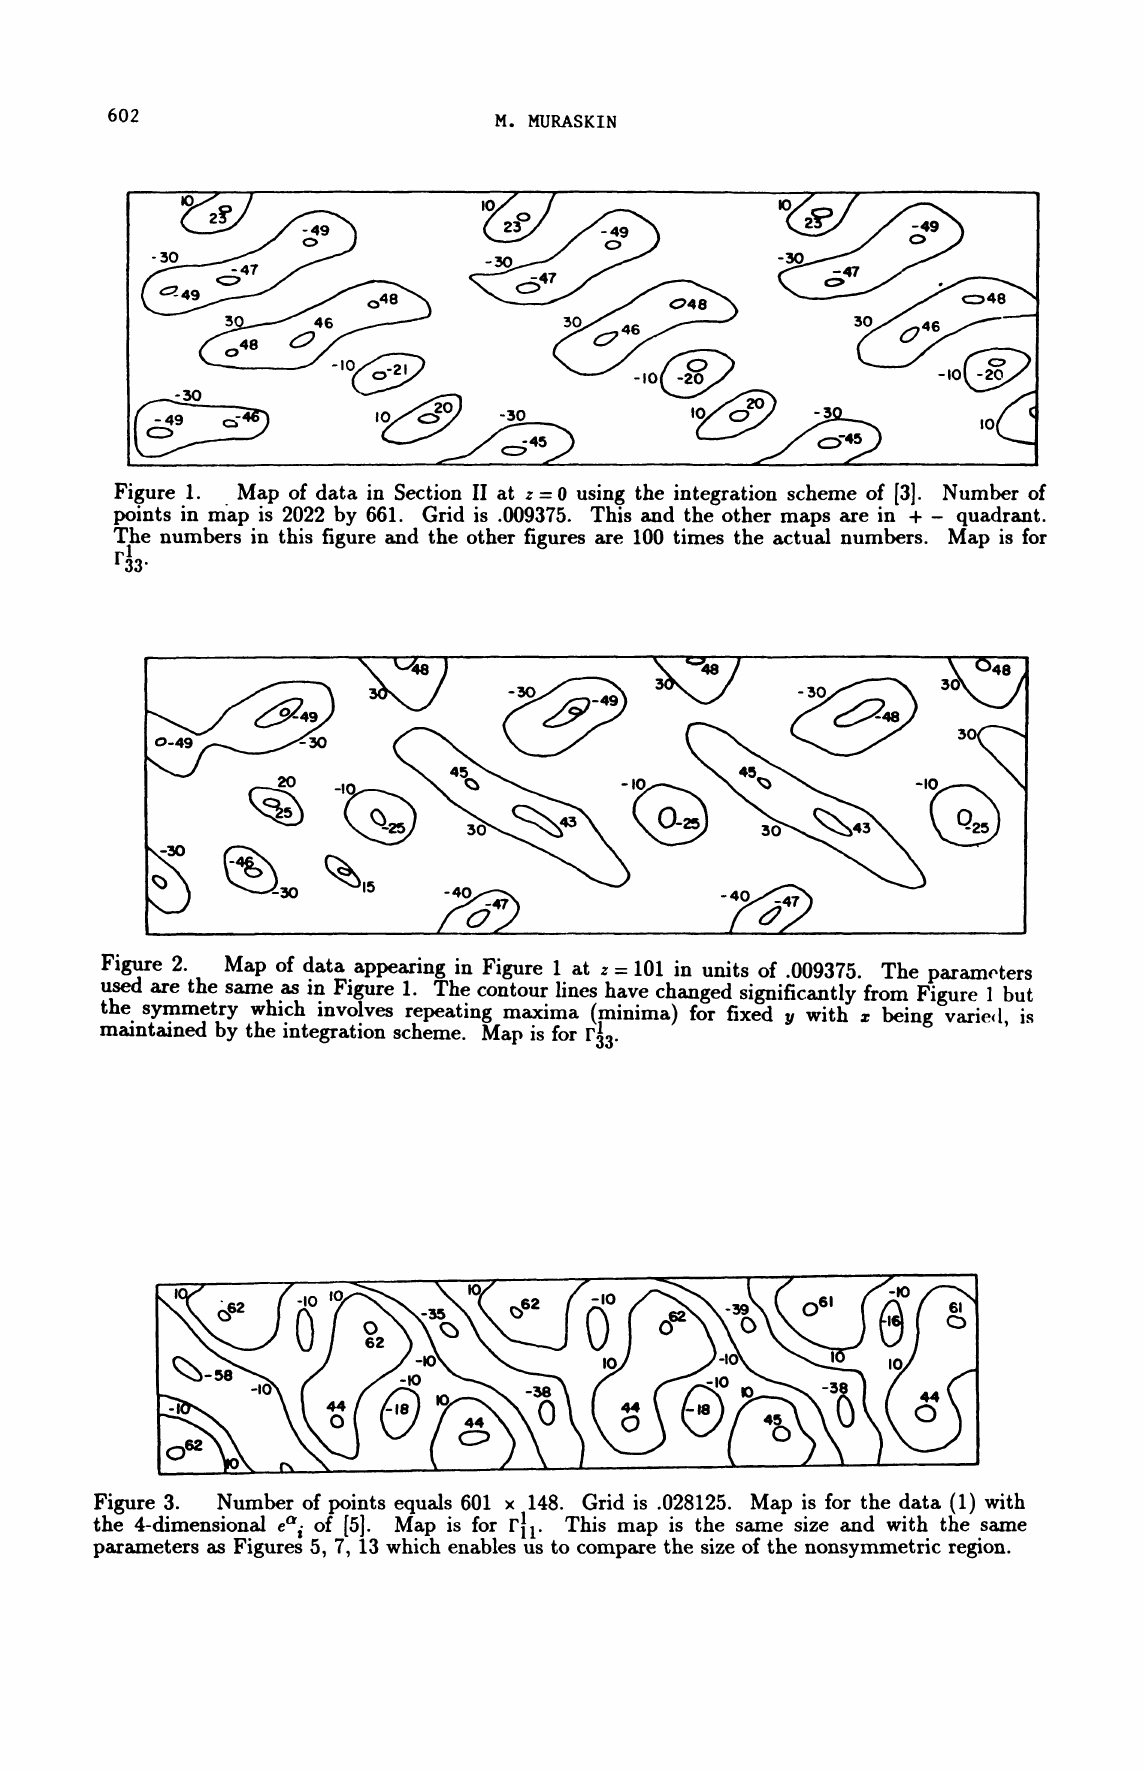
Figure 3. Number of points equals 601 x 148. Grid is .028125. Map is for the data (1) with the 4-dimensional ea: of [5]. Map is for F]l. This map is the same size and with the same parameters as Figures 5, 7, 13 which enables-6s to compare the size of the nonsymmetric